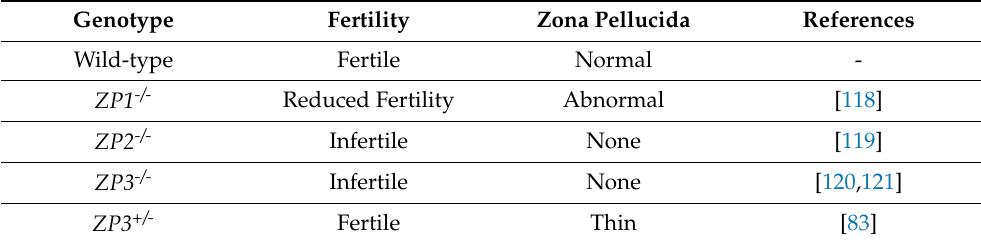
Table 3. Phenotypes of ZP1,2,3 Null Female